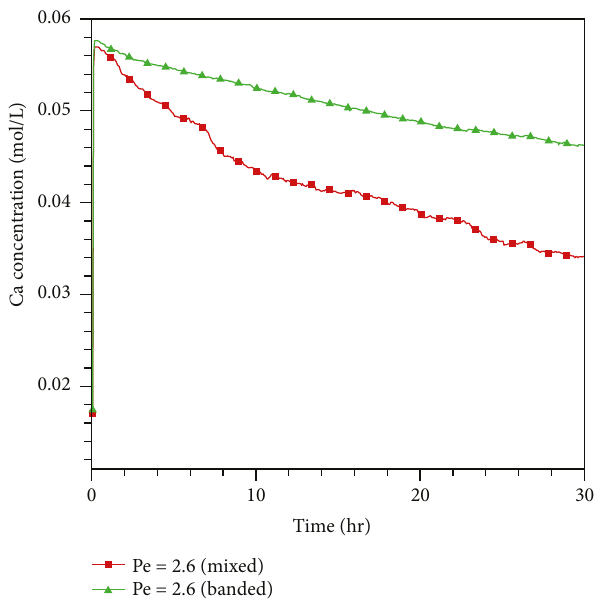
Figure 28: E ffl uent Ca concentrations versus time for mixed and banded structures when Pe=2.6.